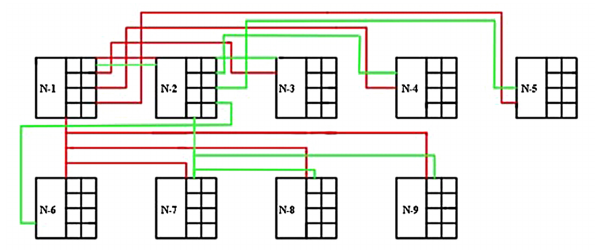
Figure 17. Eight-connected linked list.